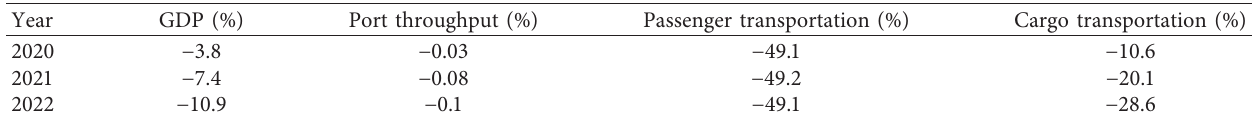
Figure 6: Simulation prediction when COVID-19 epidemic is Table 6: The impact of COVID-19 on main variables.